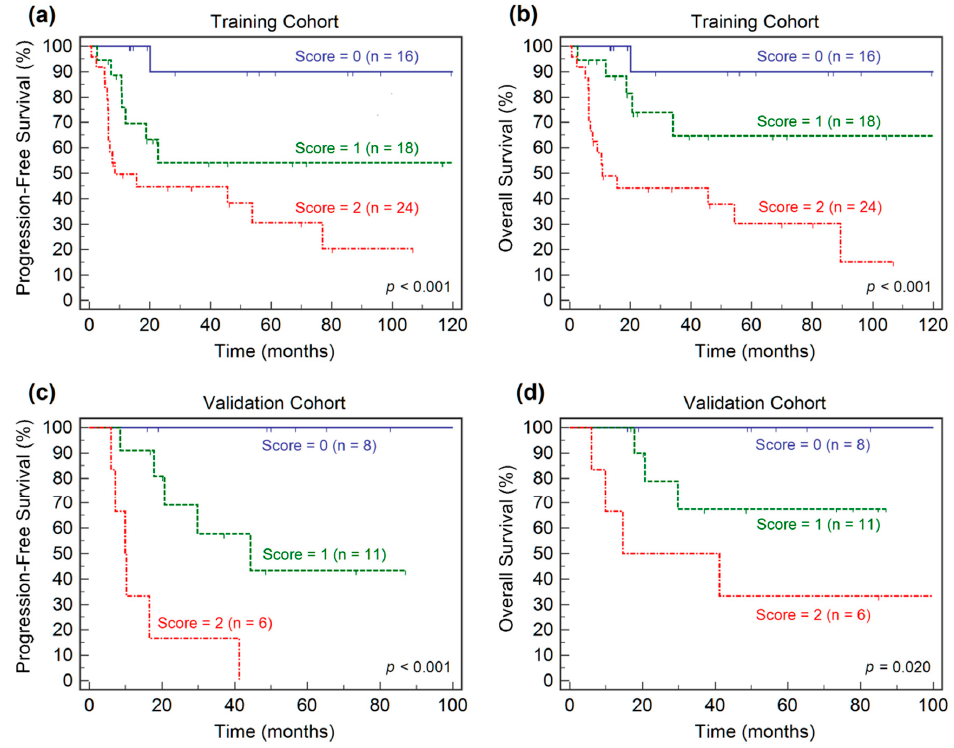
Figure 2. Kaplan–Meier estimates of progression-free survival and overall survival according to the prognostic stratifica- tion model in the training cohort ( a , b ) and the validation cohort ( c , d